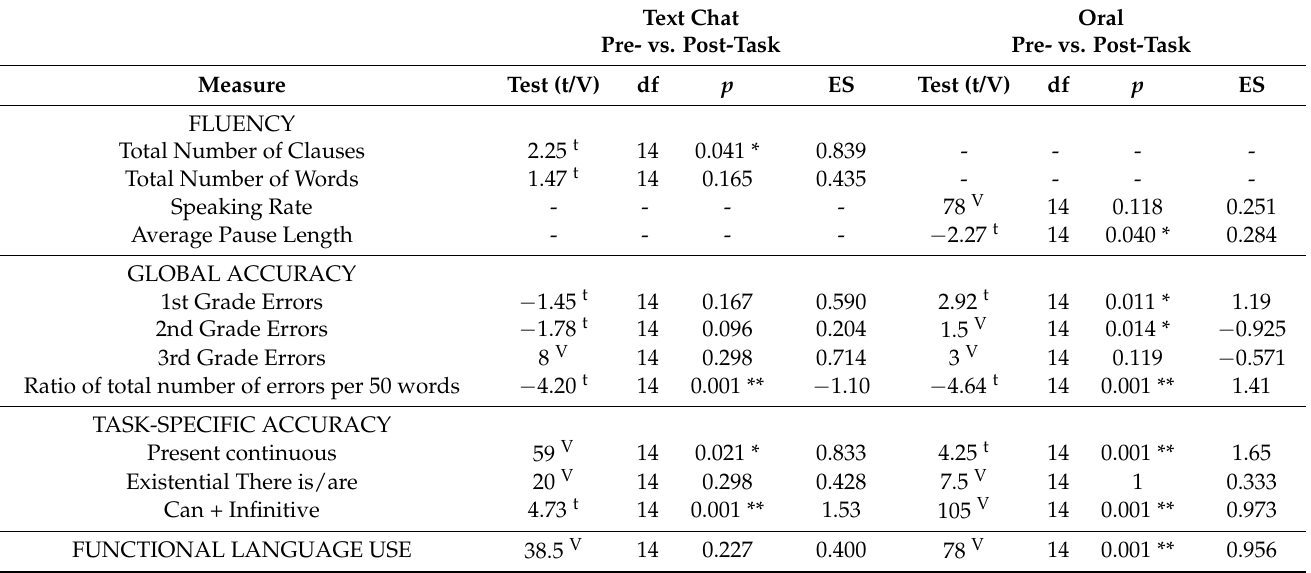
Table 3. Inferential statistics comparing pre- vs. post-task scores on text chat and oral data ( N =